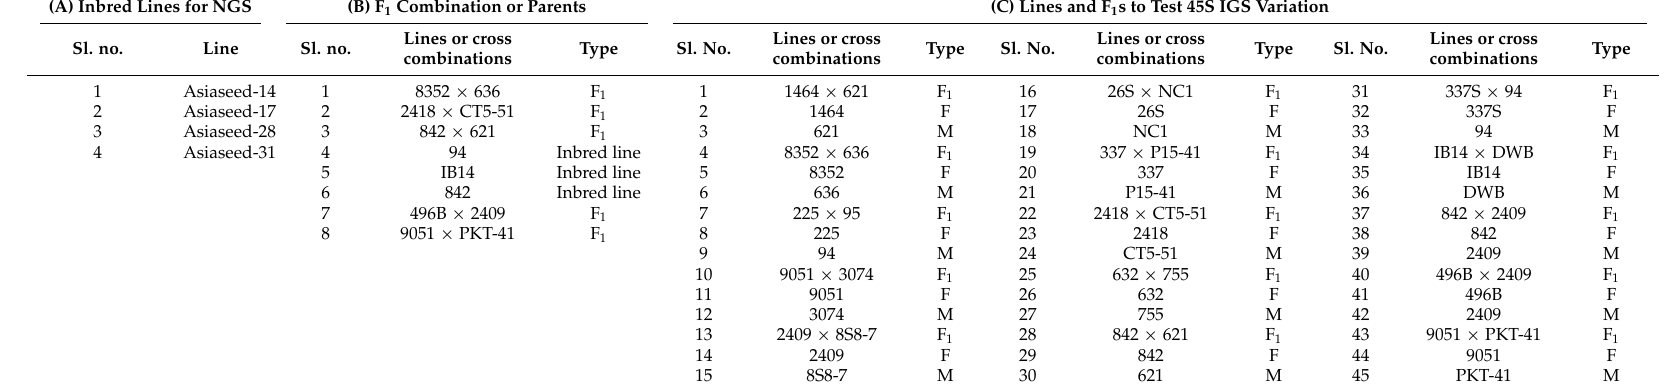
Table 3. Plant materials obtained from the Asia Seed Co., Ltd. (Seoul, Korea). Materials were used to ( A ) study whole-genome sequence of rDNA through next-generation sequencing (NGS); ( B ) clone and sequence ITS1, ITS2, and IGS regions; ( C ) test 45S IGS variation in 30 inbred lines and their 15 F 1 s, F = female parent line, M = male parent